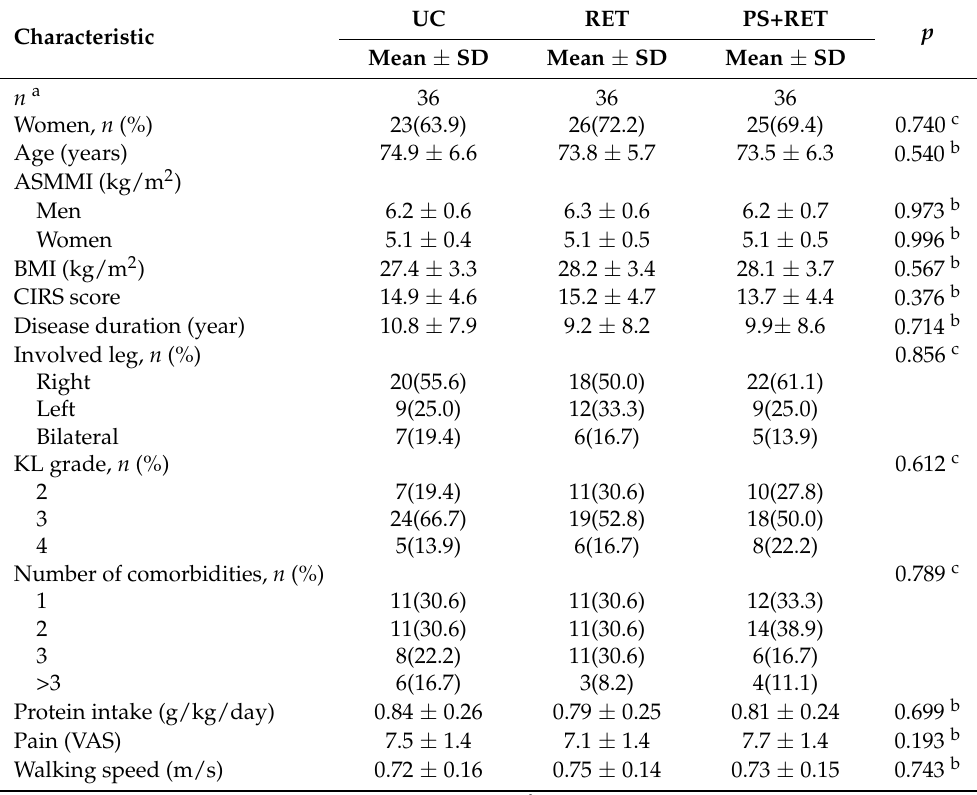
Table 1. Baseline characteristics of study